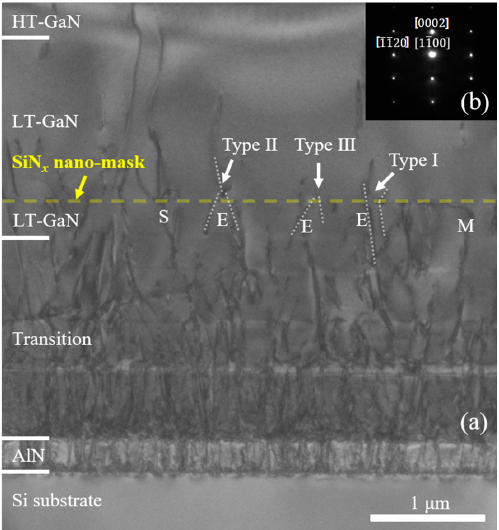
Figure 4. ( a ) Bright-field cross-sectional STEM micrograph of GaN-based HEMT structure on Si (111) with the SiN x nano-mask grown under 100 sccm SiH 4 flow rate and ( b ) Selective area electron diffraction pattern of the HT-GaN top layer taken along the [11(cid:3364)00] zone axis.